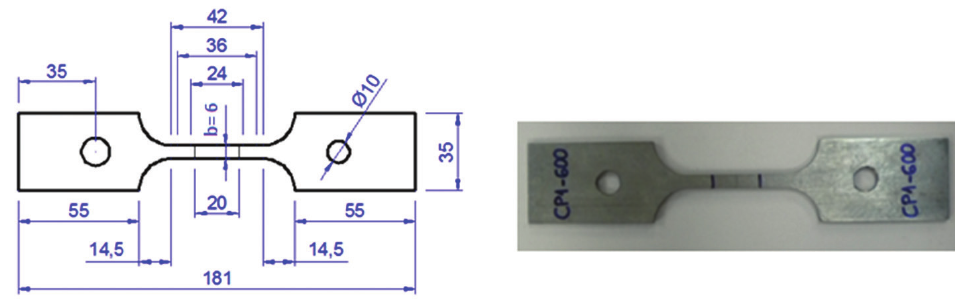
Figure 2. Dimensions of the tensile test specimens (mm).